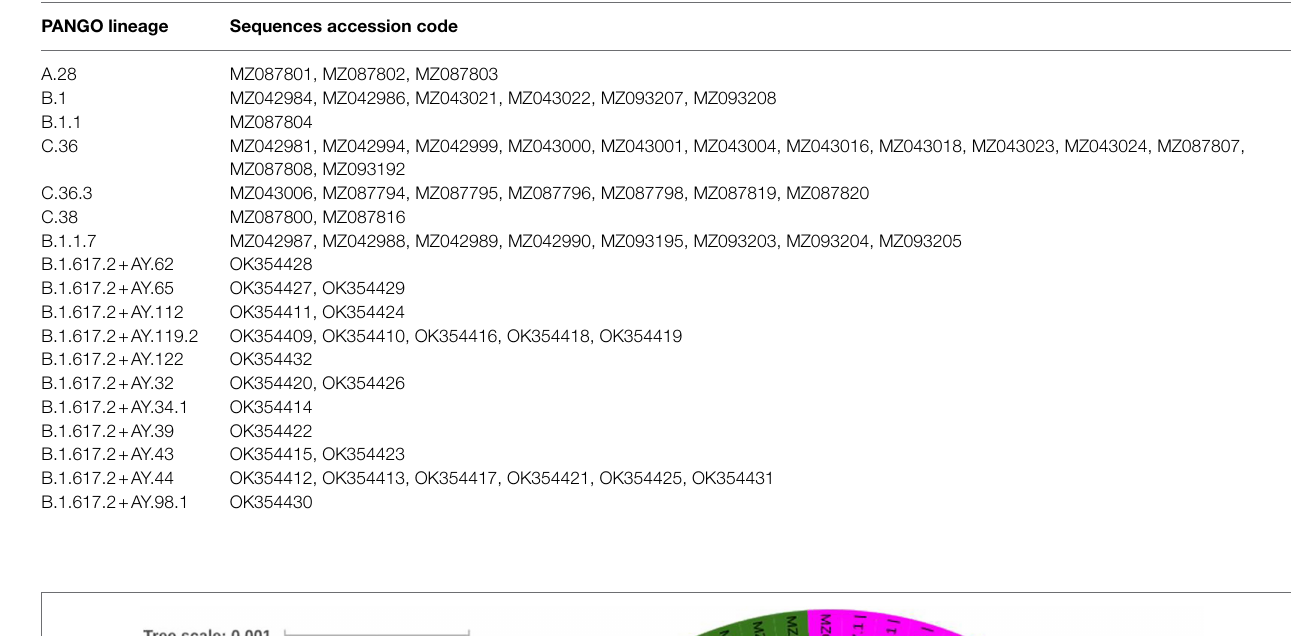
TABLE 3 | PANGO lineage of the tested